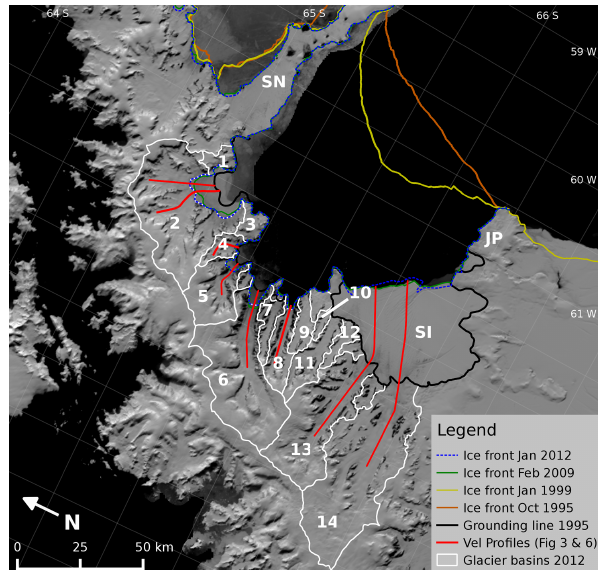
Figure 1. Overview map of glacier basins in the Larsen B region. Background: 2009 MODIS mosaic (Haran et al., 2014). Names and size of basins in Table 1. Glacier boundaries inland are based on the ASTER DEM (courtesy A. Cook). Coastlines and grounding line derived from ERS and Landsat images (ERS-1 and -2 were